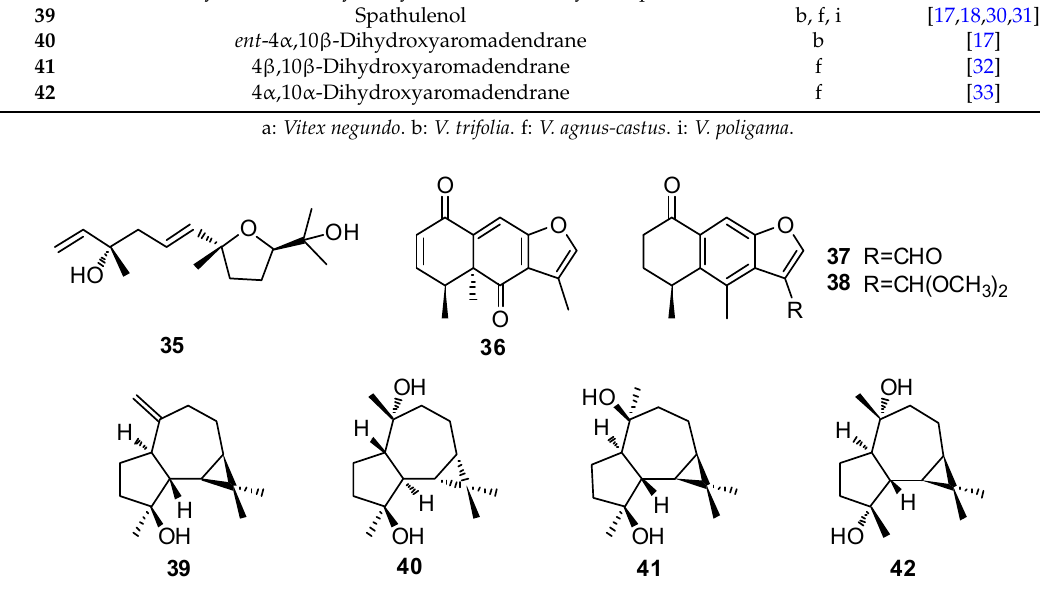
Figure 2. Structures of sesquiterpenoids 35 – 42 isolated from plants of Vitex L.